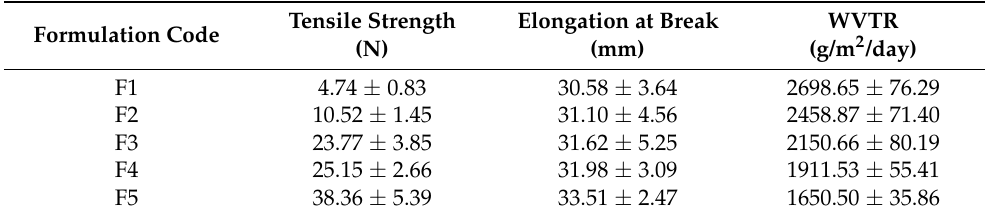
Table 2. Tensile strength, elongation at break and WVTR parameters for batches of hydrogel films ( n = 3).